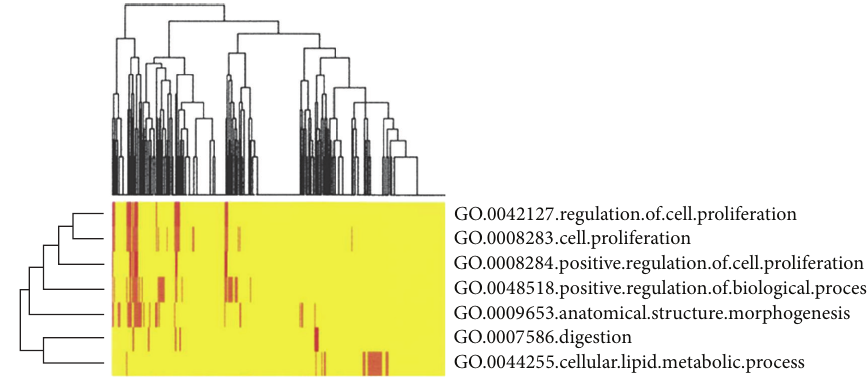
Figure 3: Clustering of overrepresented gene ontology (GO) classes in predicted targets of differential